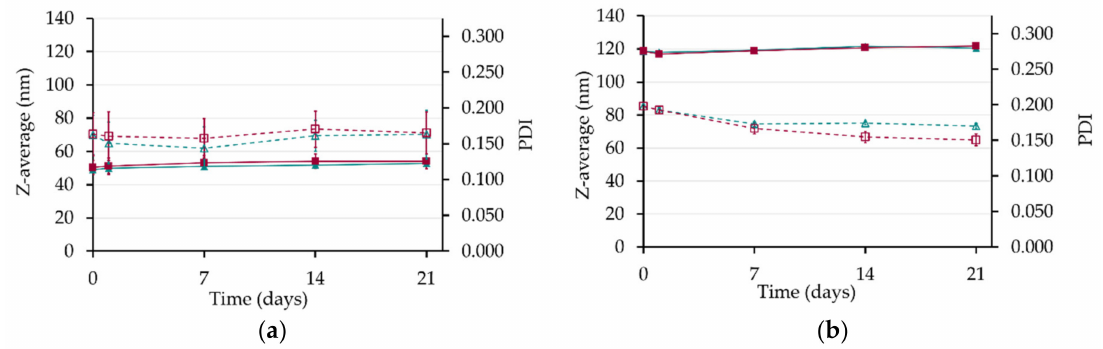
Figure 5. Stability of NE 1 ( a ) and NE 2 ( b ) estimated by the Z-average (solid line) and the PDI (dotted line) during 21-day storage at 4 ◦ C ( (cid:78) in green) and 20 ◦ C ( (cid:4) in